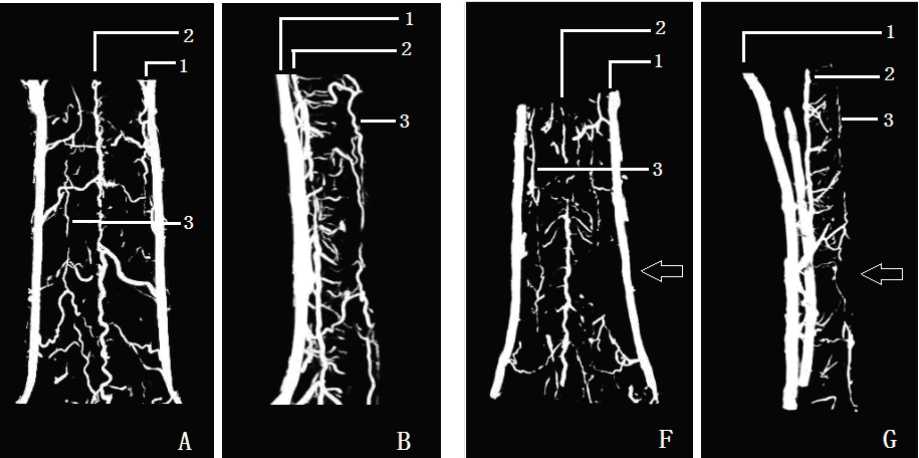
Figure 5. 3D microvessels reconstruction image of sham group on coronal and lateral view ( A , B ); cross sectionof C5 and C6 in sham group ( C , D ); sagittal view of sham group ( E ); 3D microvessels reconstruction image of compression group on coronal and lateral view ( F , G ); arrow shows the microvessels decreasing region; cross section of C5 and C6 in compression group ( H , I ); sagittal view of compression group ( J ); circle shows the difference microvascular index in C6 between sham and compression group ( D , I